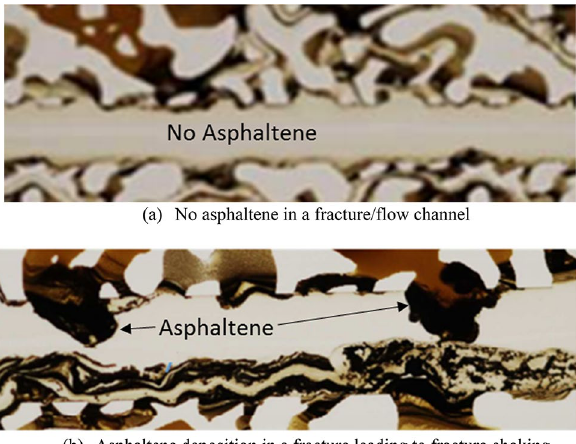
Fig. 1 Illustrations of asphaltene deposition and subsequent frac- ture choking from glass micromodel experiments (Telmadarreie and Trivedi